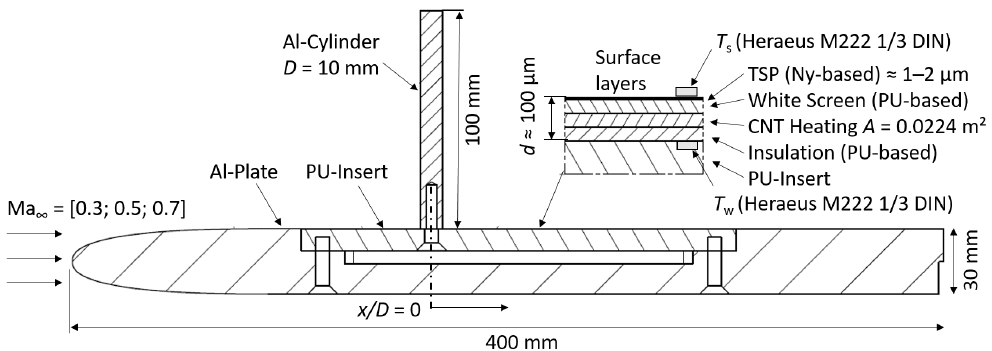
Figure 3. Flat-plate test specimen for the high-speed TSP measurements in the wind tunnel. Layer dimensions not to